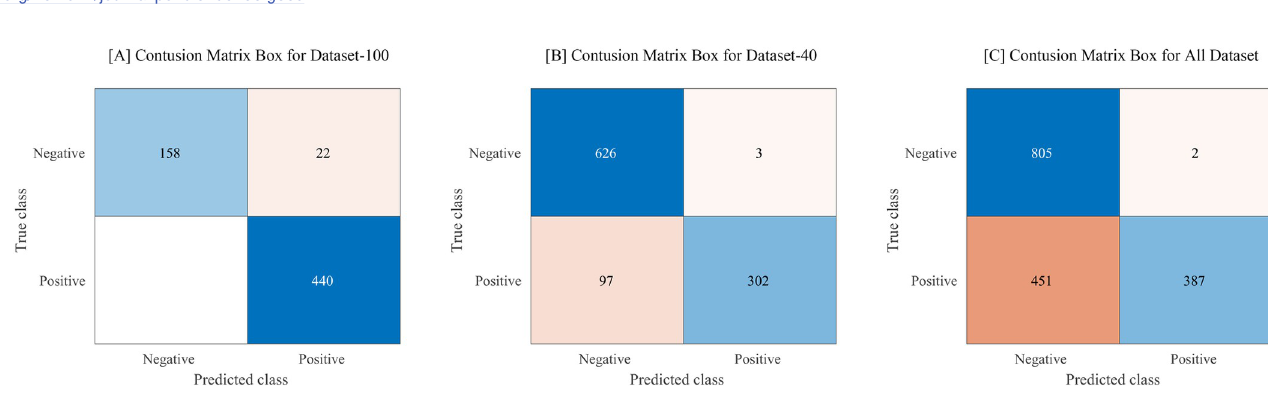
Fig 4. Confusion matrix box for (A) Dataset-100, (B) Dataset-40, and (C) all datasets.